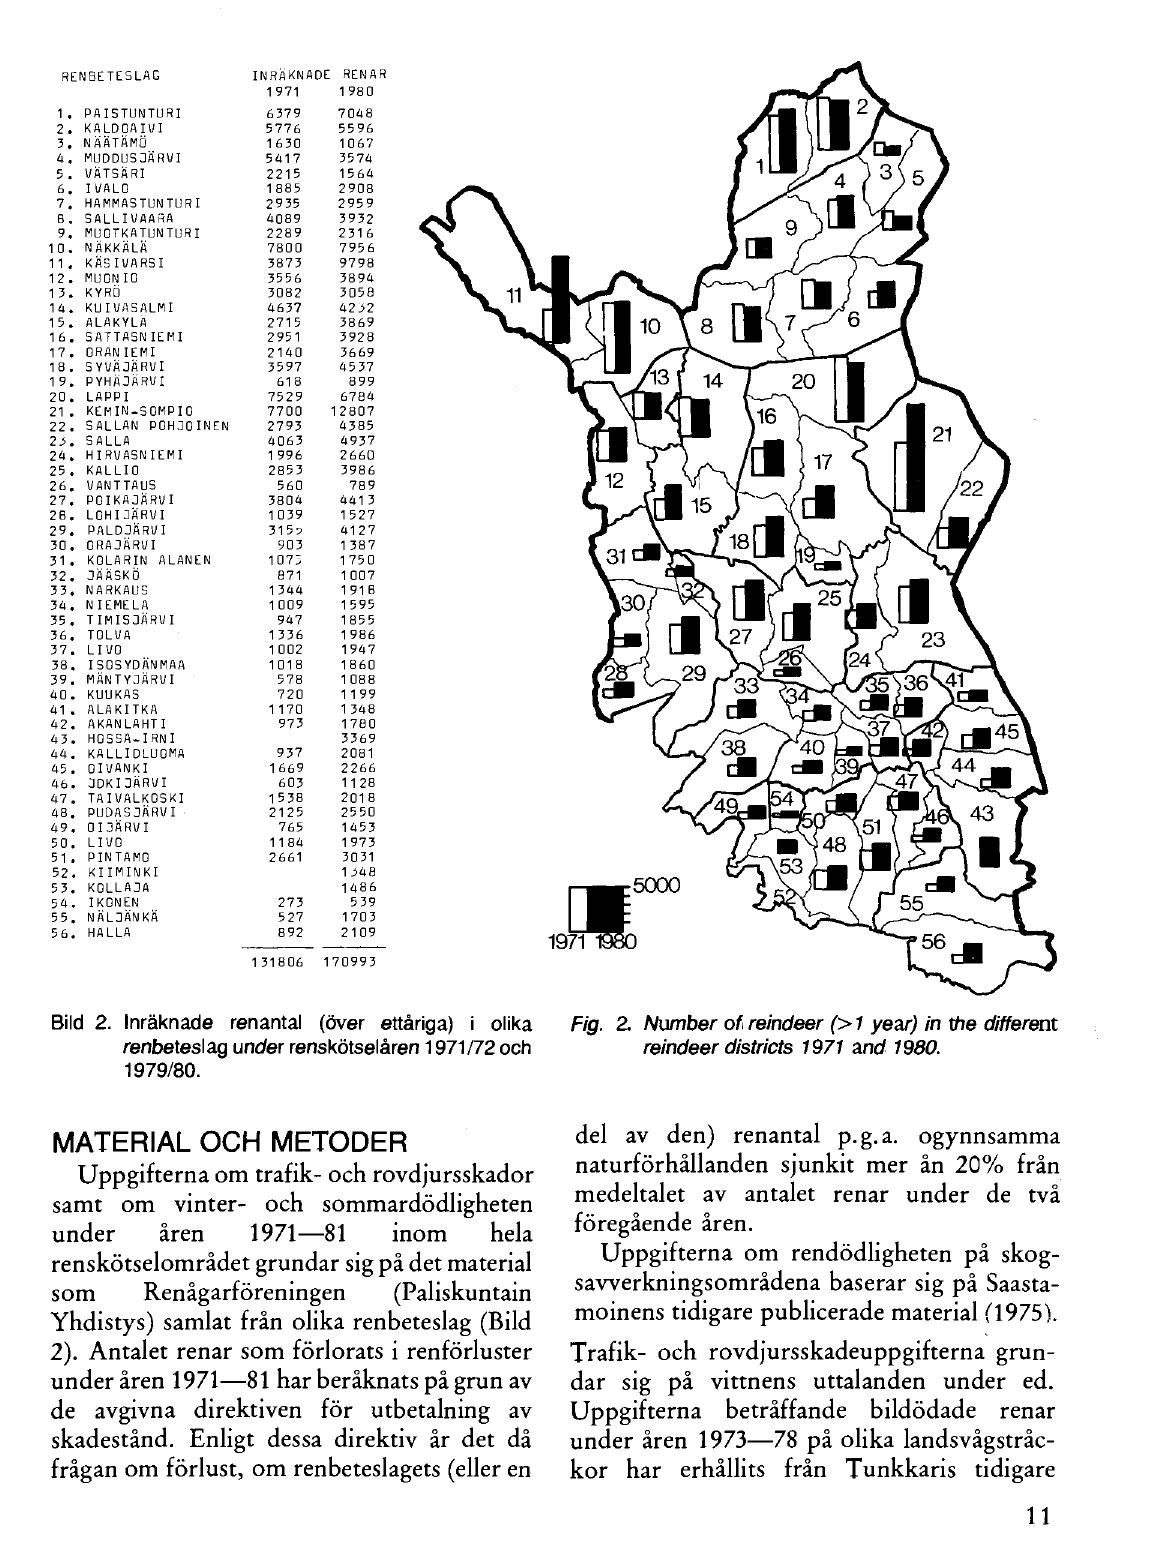
Fig. 2. Number of reindeer (> 1 year) in the different reindeer districts 1971 and